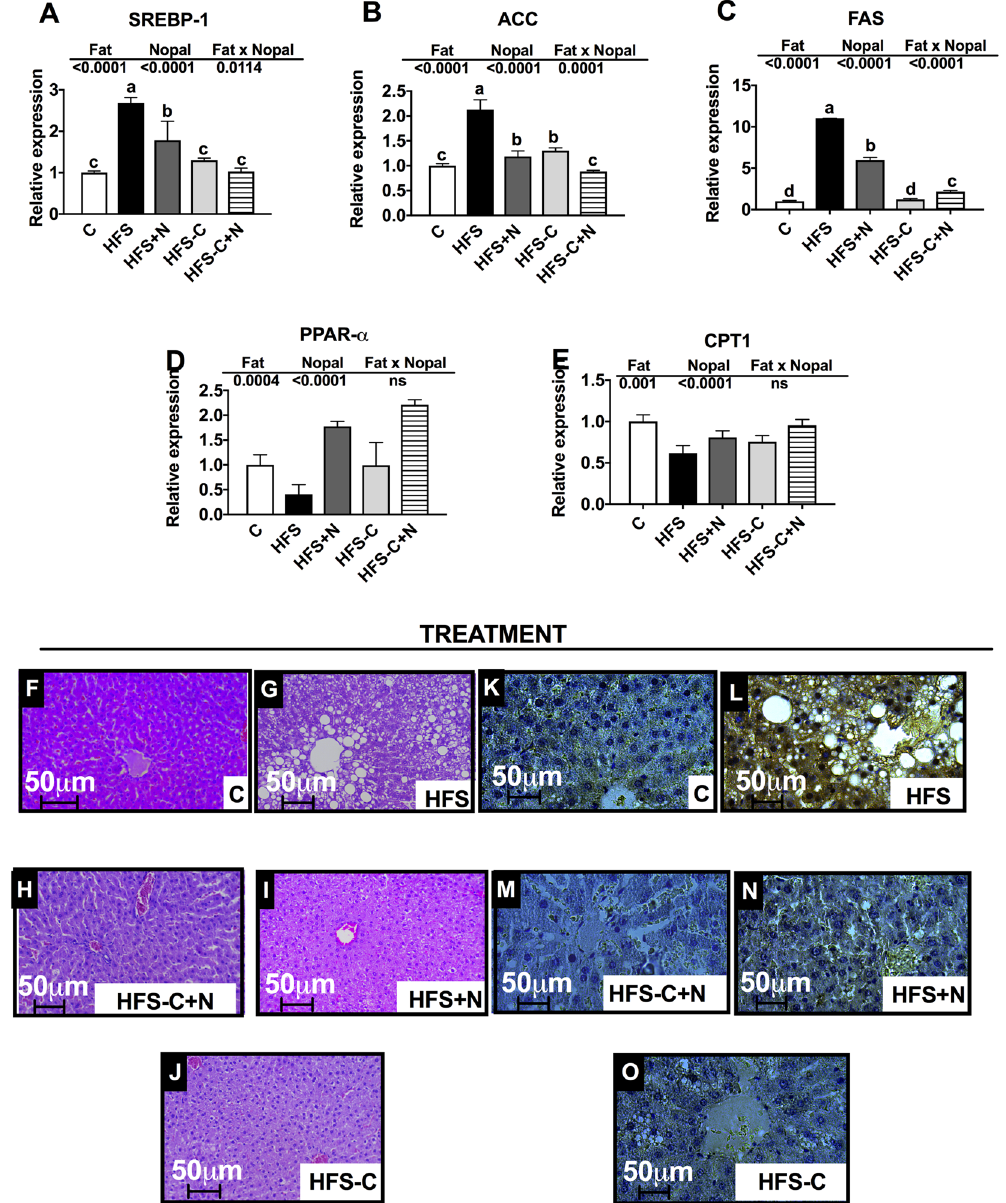
Figure 9. Nopal consumption decreases lipogenesis, hepatic steatosis and inflammation. Relative expression of ( A ) Srebp-1 , ( B ) Acetyl-CoA carboxylase Acc , ( C ) Fas , ( D ) Ppar- α and ( E ) Cpt-1 in liver of Wistar rats fed one of the following diets: control diet ( C ), high fat diet with 5% sucrose in drinking water (HFS), HFS + 5% nopal (HFS + N), and obese rats switched to C diet with (HFS-C + N) or without (HFS-C) 5% nopal. ( F – J ) Hematoxilin-Eosin staining (HE) and ( K–O ) immunohistochemistry of TNF- α in liver of these rats. Data are expressed as mean ± SEM (n = 5/group). Comparisons among groups were analysed by 2-way ANOVA followed by Fisher’s PLSD test. Different letters indicate significant differences among groups (a > b > c > d). 400X